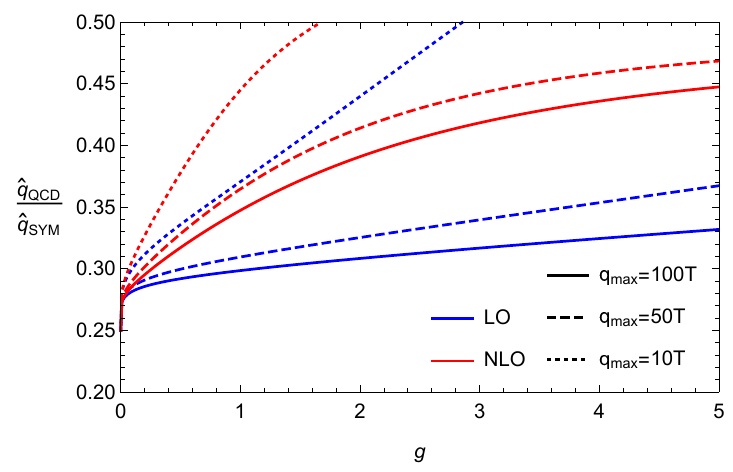
Figure 10 . The ratio of ˆ q for an adjoint QCD source to that in of q max as a function of the coupling g , at LO (blue) and NLO (red). The NLO SYM curves come from eq. (4.8) and the QCD ones from (4.9). At LO we instead integrate numerically eq. (4.10) in